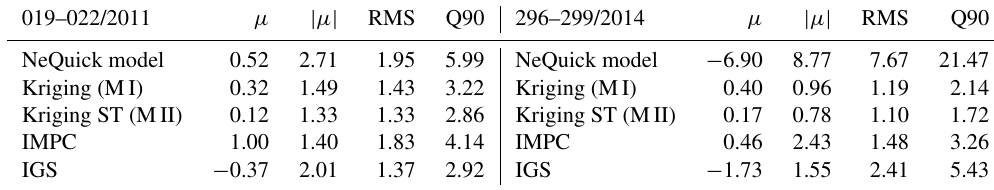
Table 2. Differential STEC (dSTEC) statistics: mean error ( µ ), absolute mean error ( | µ | ), root mean square (RMS) and 90% quantile (Q90) in TECU for DOY 019–022/2011 and DOY